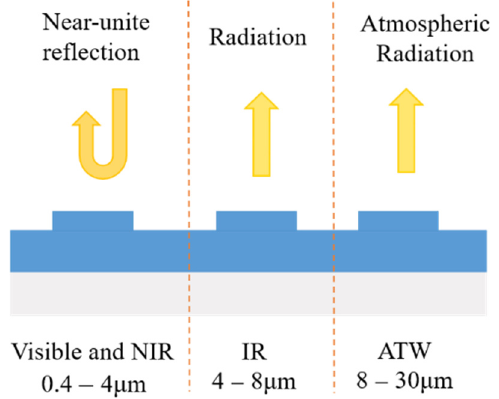
Figure 1. Scheme of solar reflection and the thermal radiation properties of a daytime radiative cooler. ATW refers to the atmospheric transparent window [14].